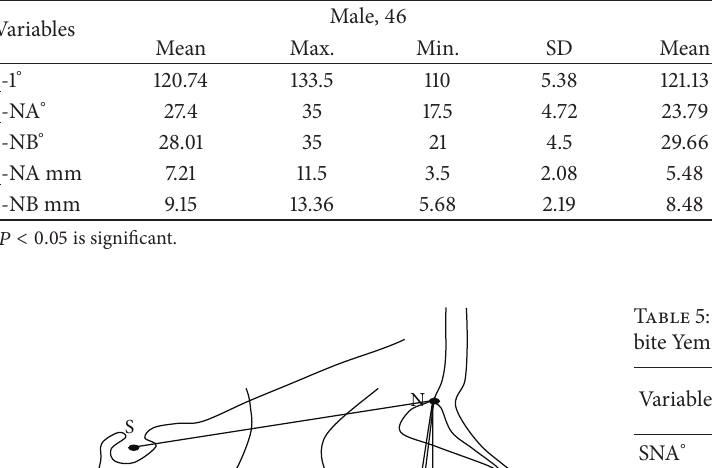
Table 4: Distribution of dental variables among Yemeni adults with anterior open bite.